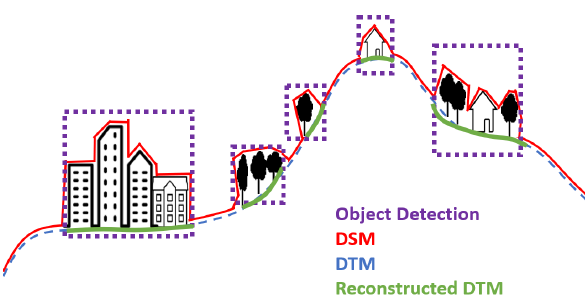
Figure 6. DSM vs DTM.